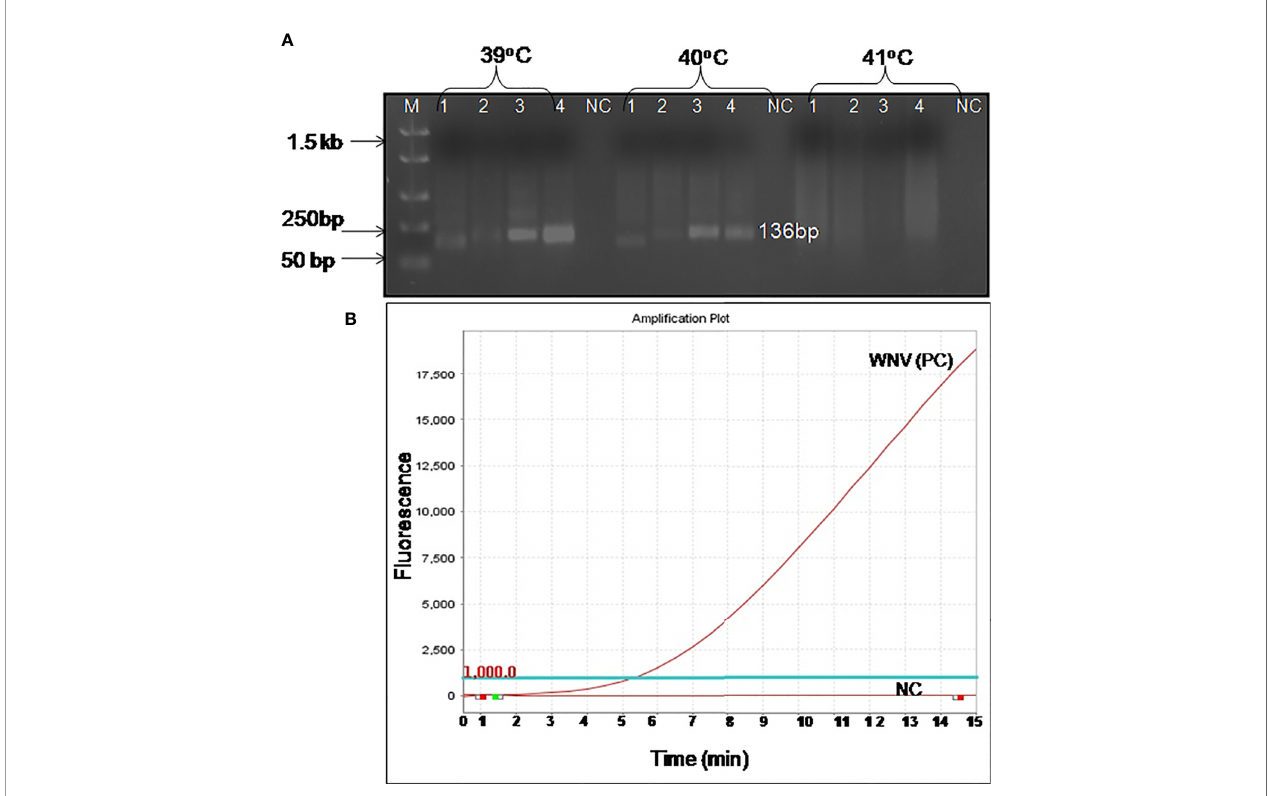
FIGURE 1 | Optimal detection conditions of reverse transcription recombinase polymerase ampli fi cation (RT-RPA) assay. (A) Basic RT-RPA assay run with different sets of the designed primers and temperatures (39°C, 40°C, and 41°C). M-DNA Marker, Lanes 1 – 4, RPA amplicons from reactions incubated for 30 min, NC- Negative control. (B) Optimization of real-time RT-RPA assay. Optimal primers and probe combinations for the ampli fi cation of the WNV env gene by real-time RT- RPA